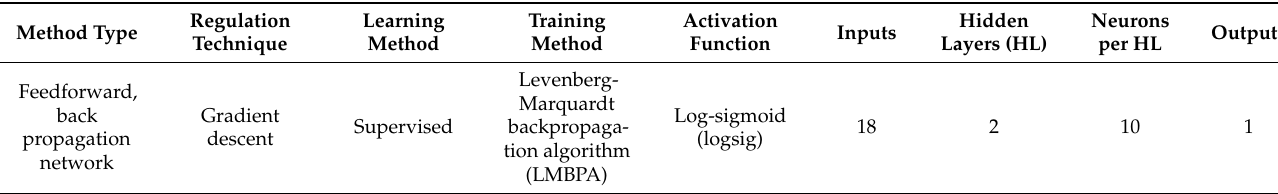
Table 1. General characteristics of the ANN model.